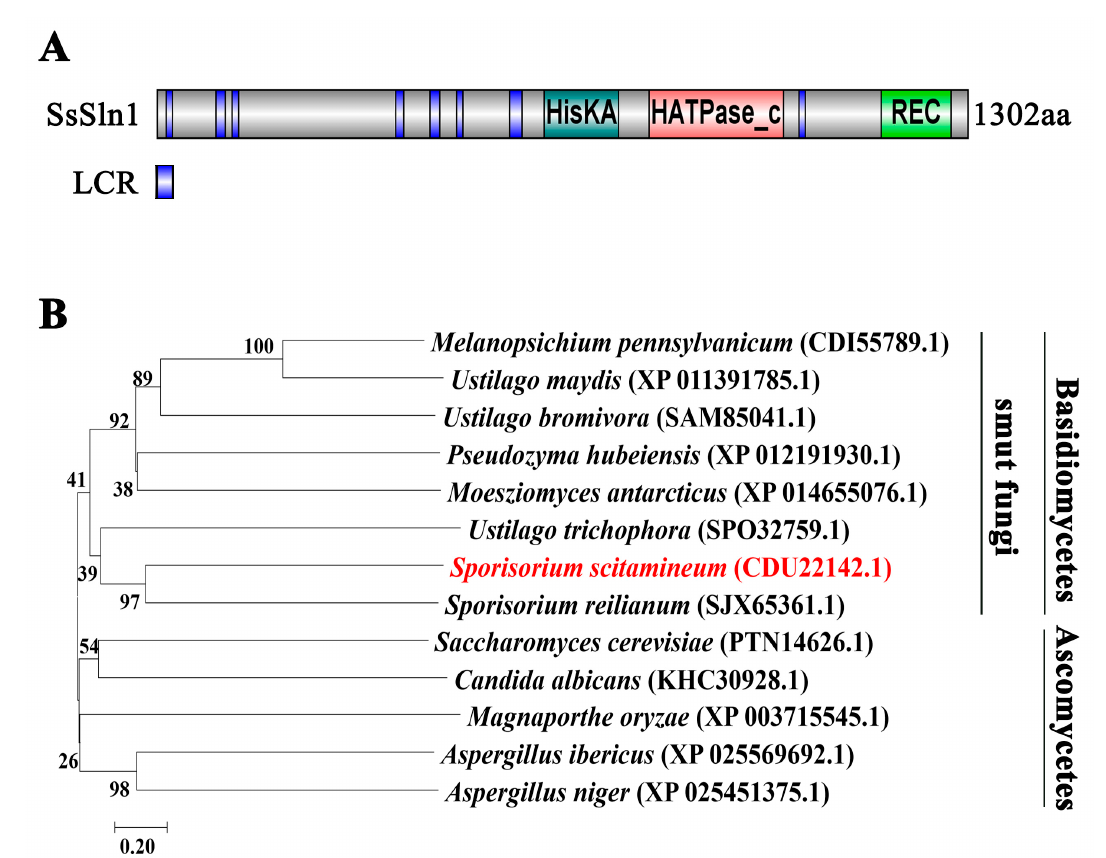
Figure 1. Phylogenetic analysis of SsSln1 protein. ( A ) Domain arrangement of S. scitamineum SsSln1 protein was performed using the SmartBLAST tool (https://blast.ncbi.nlm.nih.gov/smartblast/ (accessed on 8 June 2021)). LCR represents low- complexity regions. ( B ) The amino acid sequence of SsSln1 protein was used to search orthologous proteins through the BLASTp tool. The phylogenetic tree was constructed from the Sln1 proteins of Melanopsichium pennsylvanicum (CDI55789.1), U. maydis (XP 011391785.1), Ustilago bromivora (SAM85041.1), Pseudozyma hubeiensis (XP 012191930.1), Moesziomyces antarcticus (XP 014655076.1), U. trichophora (SPO32759.1), S. scitamineum (CDU22142.1), S. reilianum (SJX65361.1), S. cerevisiae (PTN14626.1), C. albicans (KHC30928.1), M. oryzae (XP 003715545.1), Aspergillus ibericus (XP 025569692.1) and Aspergillus niger (XP 025451375.1) using neighbor-joining method in MEGA 7.0 software [45]. Gap extension = 0.2.